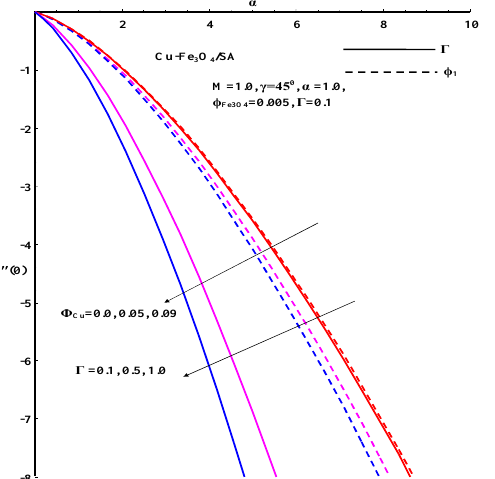
Figure 10. Effect of M and inclined angle parameters on skin friction coefficient.